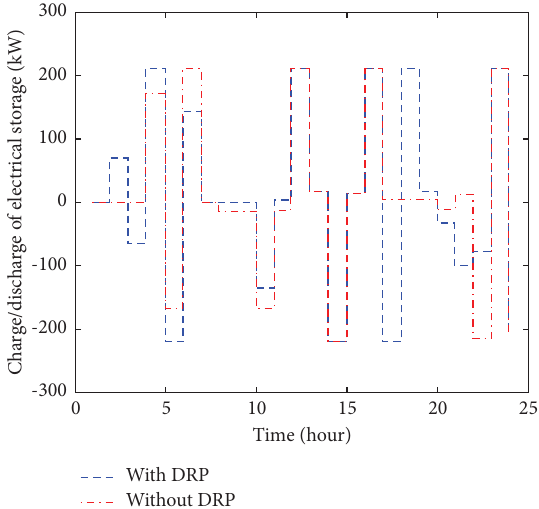
Figure 17: Charge and discharge of the electrical storage.